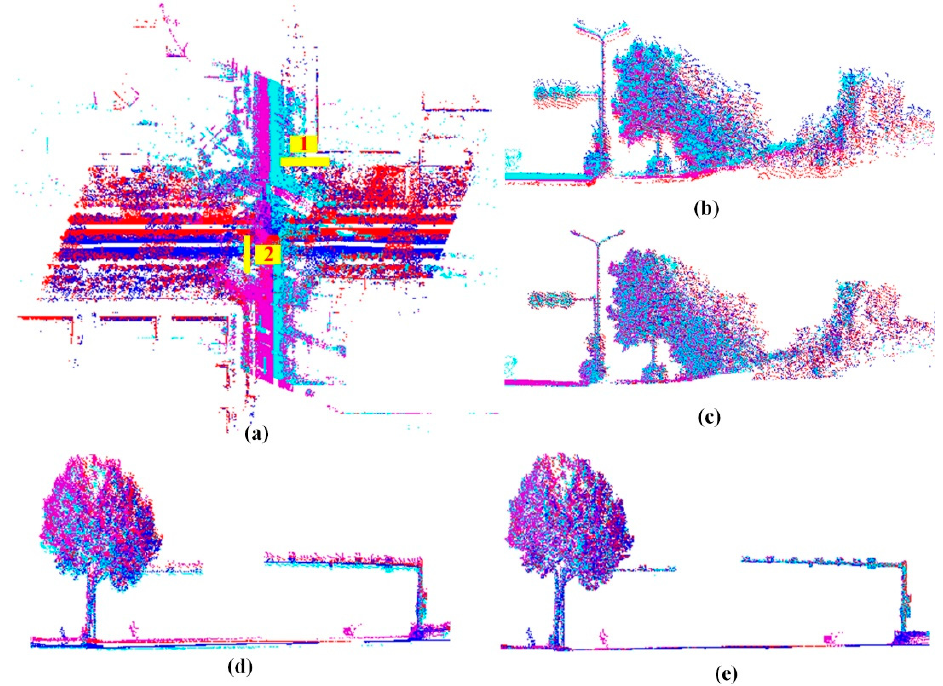
Figure 6. Multi-strip point clouds before and after boresight angle calibration in “MLS2”. ( a ) raw point clouds; ( b ), ( c ) point clouds of cross section 1 and cross section 2 respectively before boresight calibration; ( d ), ( e ) point clouds of cross section 1 and cross section 2 respectively after boresight calibration. Points scanned from different strips have different colors.